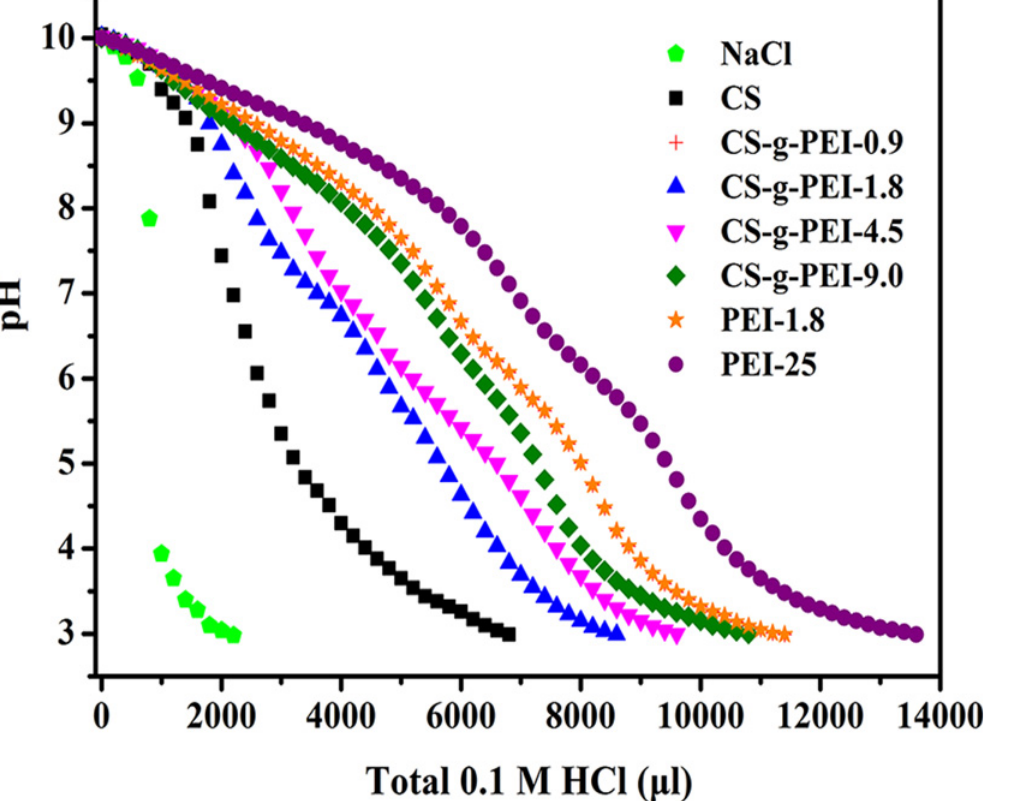
Fig 5. Buffering capacity in 150 mM NaCl solutions. NaCl blank ( ⬟ ), CS ( & ), CS- g -PEI-0.9 (+), CS- g -PEI-1.8 ( ▲ ), CS- g -PEI-4.5 ( ▼ ), CS- g -PEI-9.0 ( ◆ ), PEI-1.8 ( $ ) and PEI-25 ( ● ).